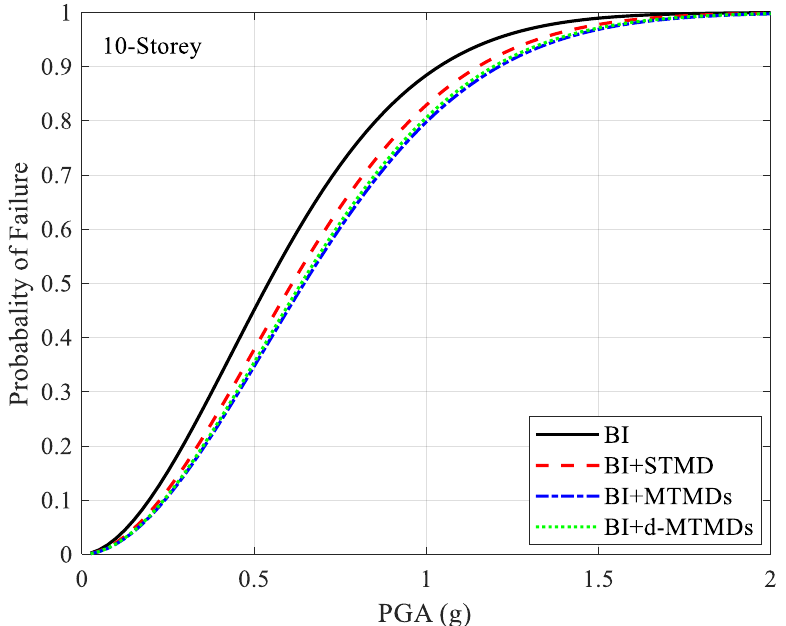
Figure 11. Bearing displacement simplified fragility curves for 10-story base-isolated building equipped with TMDs.